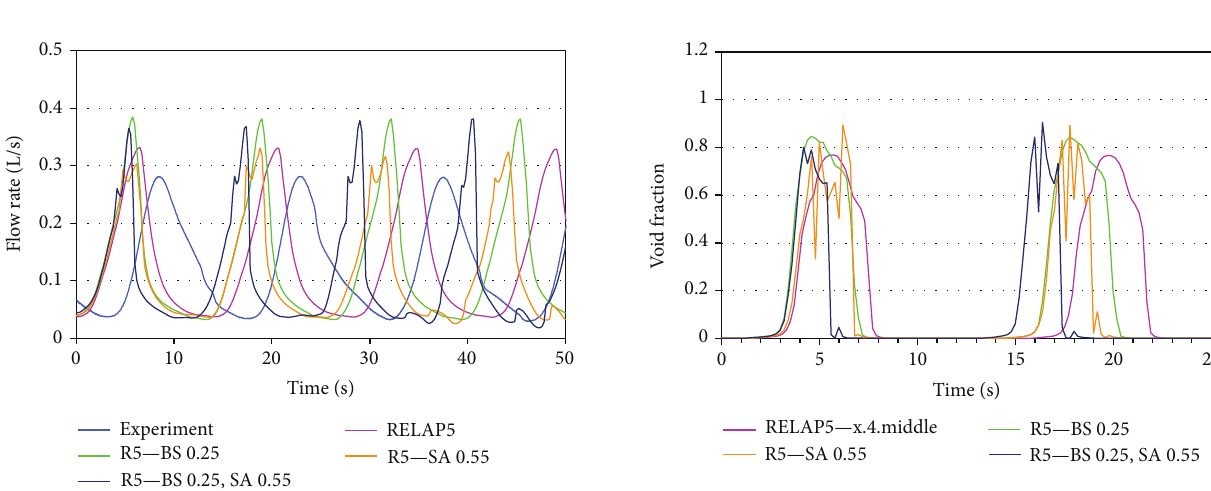
Figure 16: Inlet flow rate: experimental and RELAP5 data obtained with different flow regime transition boundaries.